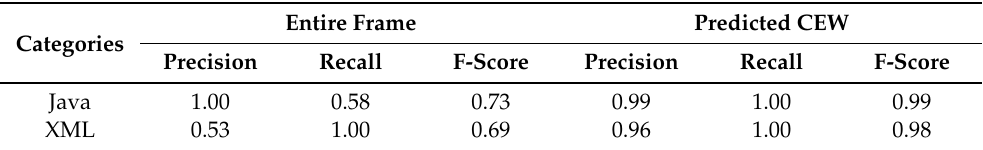
Table 4. The classification results of predicting the written language of the entire frame as compared to that of the code-editing window